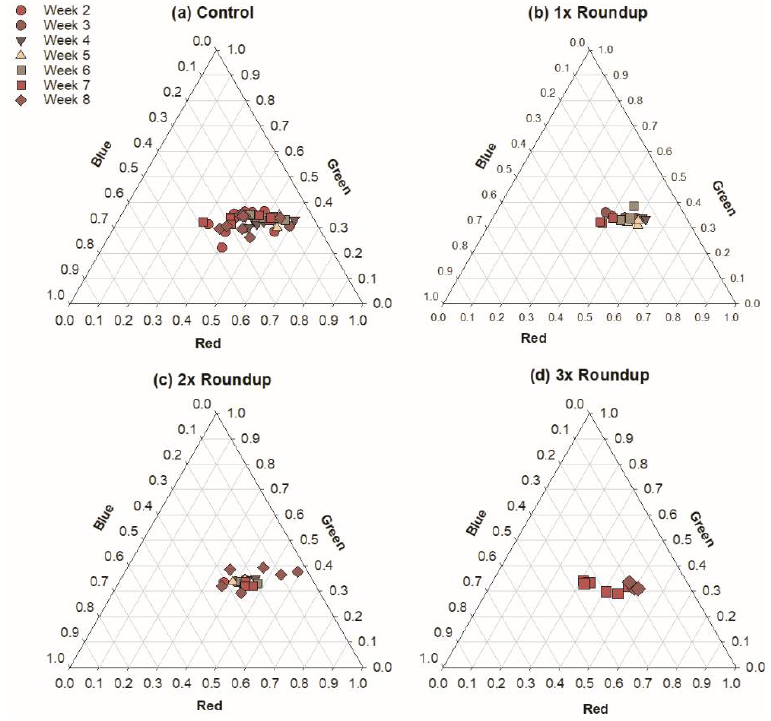
Figure 2. Visible microbial colony colors measured from the ditch habitat for each level of Roundup addition. Each axis is a proportion of 255, maximal value for each color.